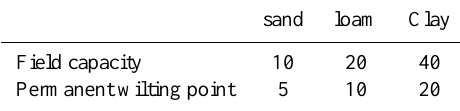
Table 7. Soil water content ( θ s in %) at field capacity and permanent wilting point according to soil type from Lambers et al.